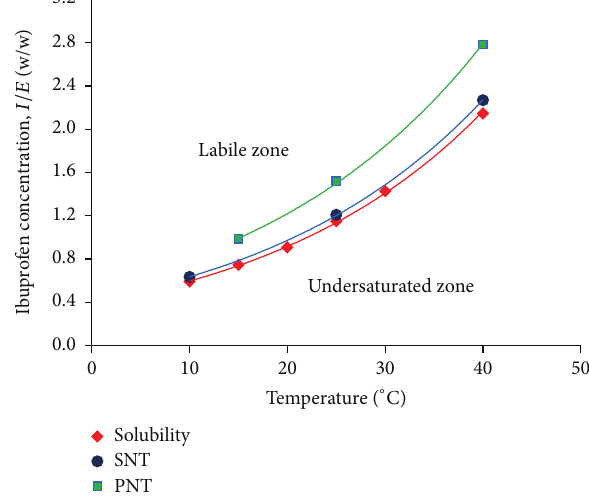
Figure 4: Phase diagram for ibuprofen in ethanol with superim- posed SNT and PNT